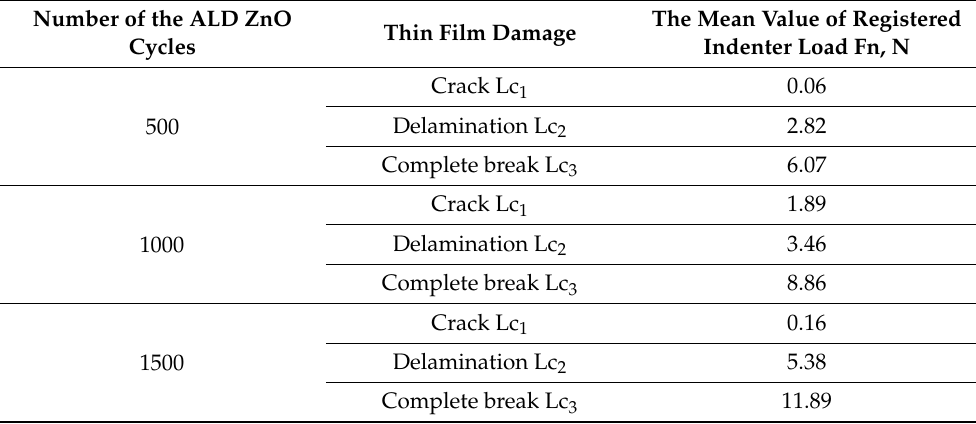
Table 2. Test results for the ZnO thin film adhesion to the surgical steel